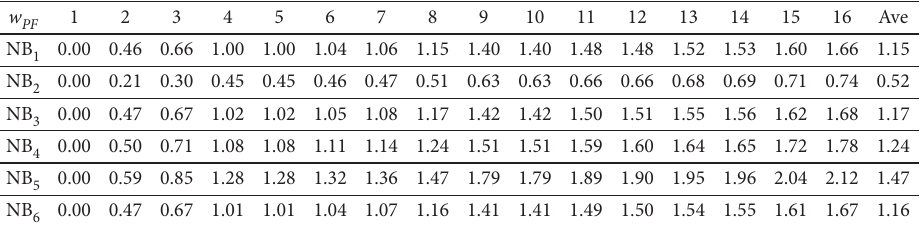
with FS-OWAIMAM II PF